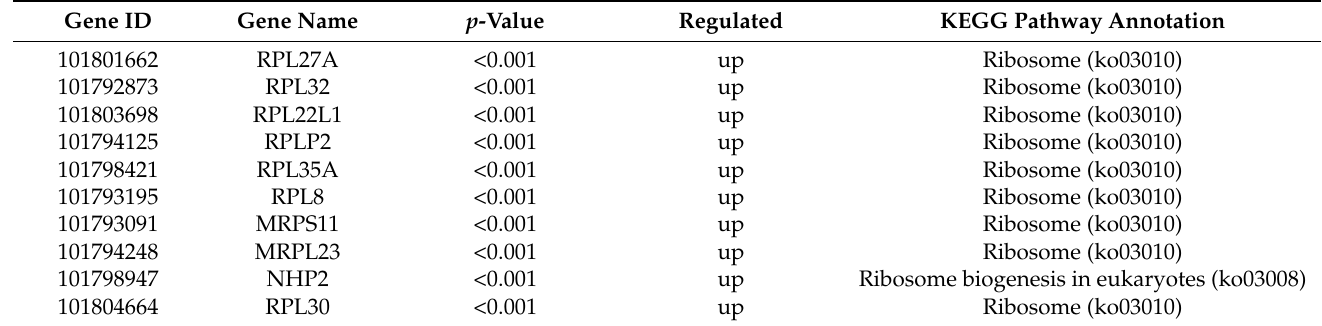
Table 4. The top 10 DEGs with known functions contained in ribosome pathway.